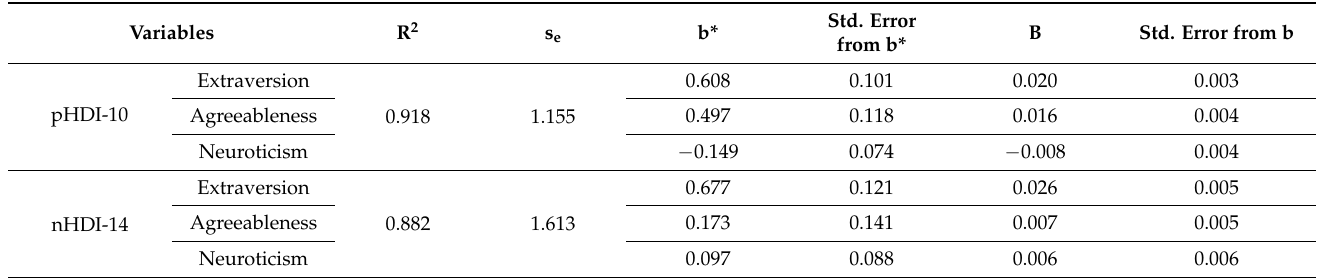
Table 7. Correlations between indices of diet health quality (pHDI-10 and nHDI-14) and personality traits in the big five model (multiple regression